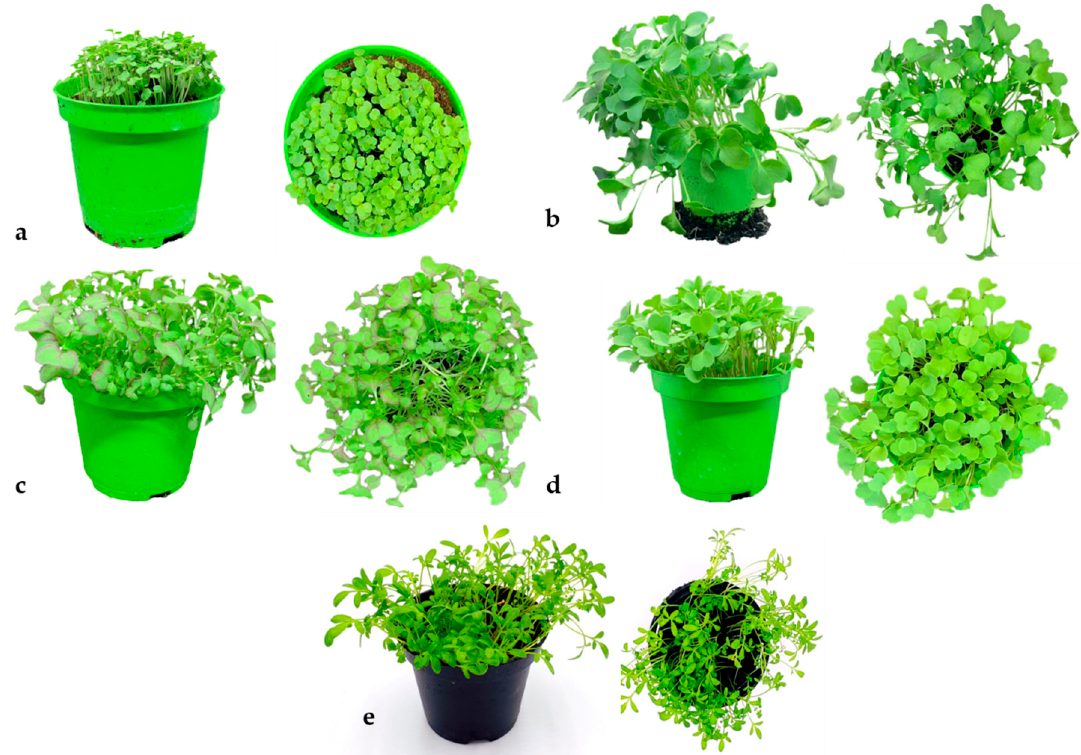
Figure 1. Photos of the analyzed plant material. ( a ) Broccoli ( Brassica oleracea L.); ( b ) Daikon ( Raphanus raphanistrum subsp. sativus (L.) Domin); ( c ) Mustard ( Brassica juncea (L.) Czern.); ( d ) Rocket salad ( Eruca vesicaria (L.) Cav.); ( e ) Watercress ( Nasturtium officinale R.Br.).